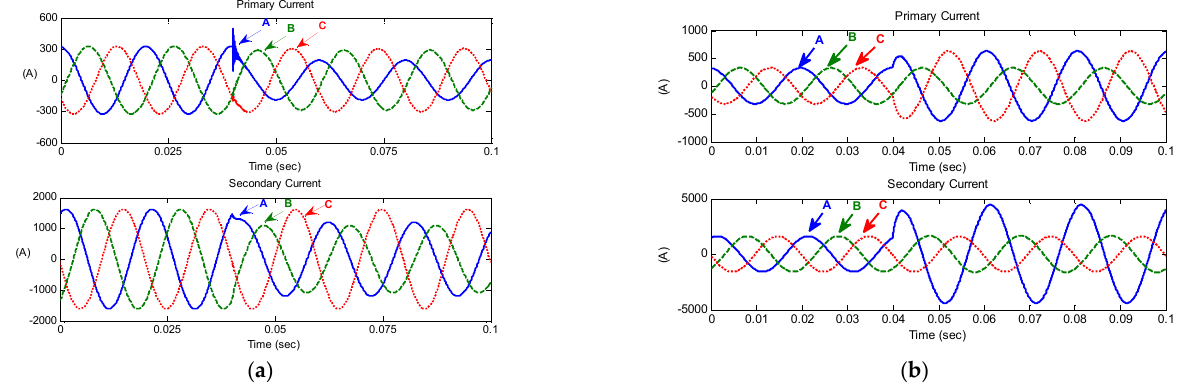
Figure 5. External fault simulation’s primary and secondary currents: ( a ) the scenario of a high-voltage winding malfunction; ( b ) the scenario of a low-voltage winding malfunction.